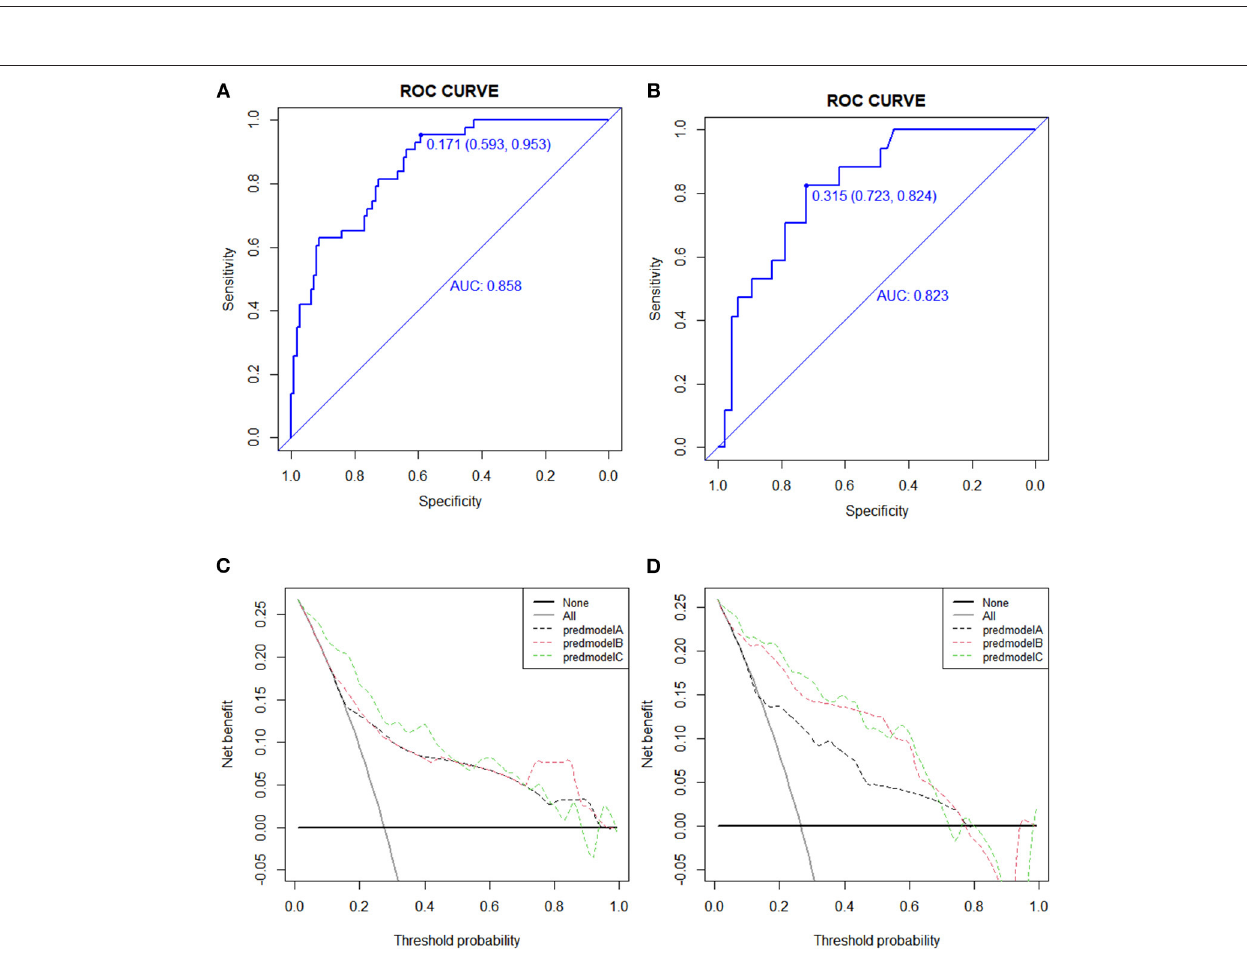
Frontiers in Surgery |